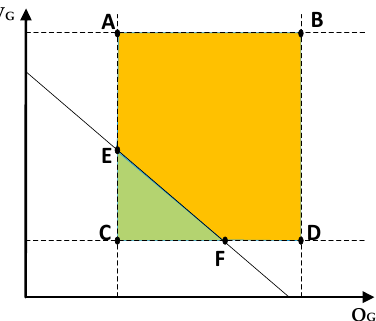
Figure 7. Influence of 𝑁𝑃𝐺 on the energy storage cost decisions of power grid enterprises.